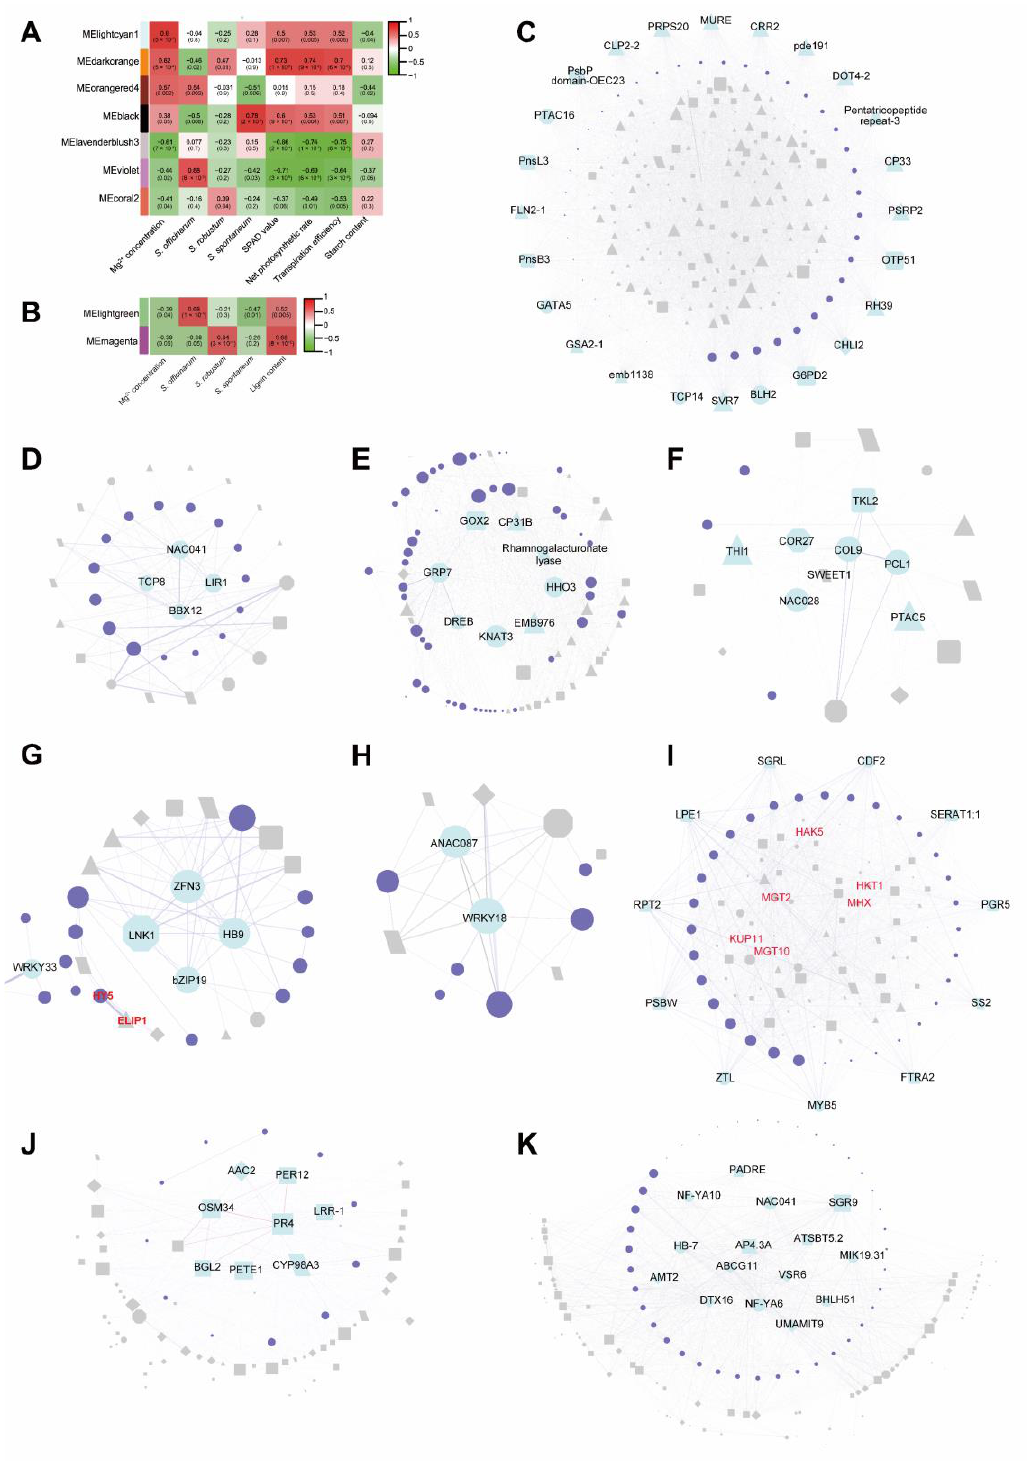
Figure 5. WGCNA analysis using the DEGs in leaves and roots of three Saccharum species. ( A ) heat map of module − trait correlation of Mg 2+ concentration associated modules in roots; ( B ) heat map of module − trait correlation of Mg 2+ concentration associated modules in leaves; ( C − I ) Network visual- ization of ( C ) orangered4, ( D ) lightcyan1, ( E ) black, ( F ) darkorange, ( G ) lavenderblush3, ( H ) coral2 and ( I ) violet modules, respectively, which associated with Mg 2+ concentrations. ( J , K ) Network vis- ualization of lightgreen and magenta modules which associated with Mg 2+ concentrations.